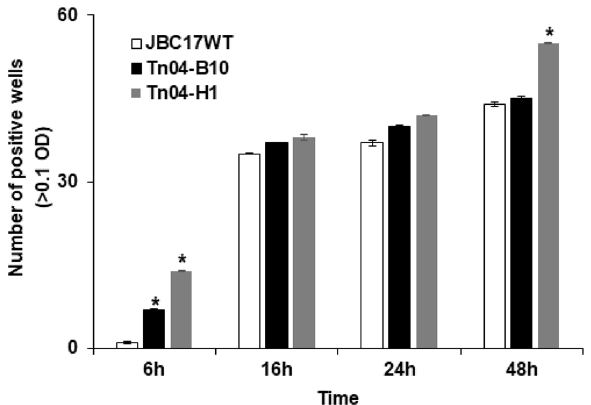
Figure 5. Number of carbon substrates utilized by Pseudomonas putida JBC17 and its flagella-related mutants. The number of wells that show color development by flagella-deficient mutant, Tn04-B10 ( fliH ) and Tn04-H1 ( fliR ), were assayed using Biolog GN2 microplate at 6, 16, 24, and 48 h after incubation and compared to the wild type. Data are presented as the mean ± standard deviation of three replicates, and values marked by an asterisk (*) are significantly different at each time point at P < 0.05 according to Student’s